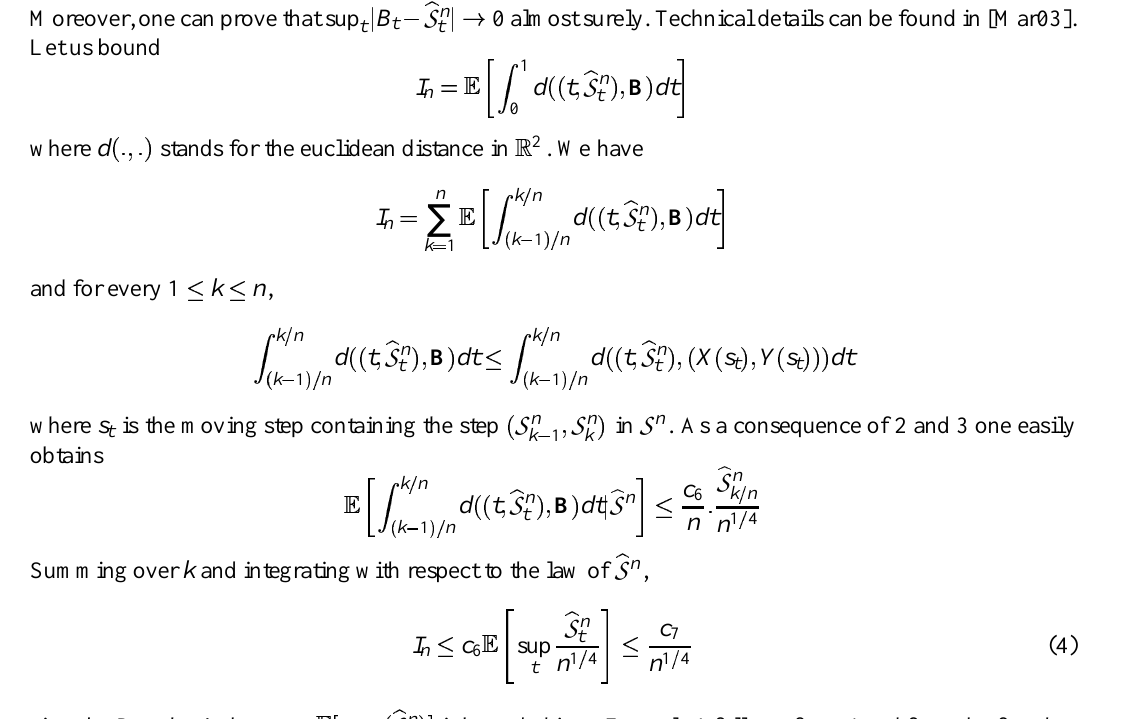
a q n i , and at table number k (cid:1)(cid:2) n (cid:2) (cid:5) (cid:5) (cid:0) (cid:3)